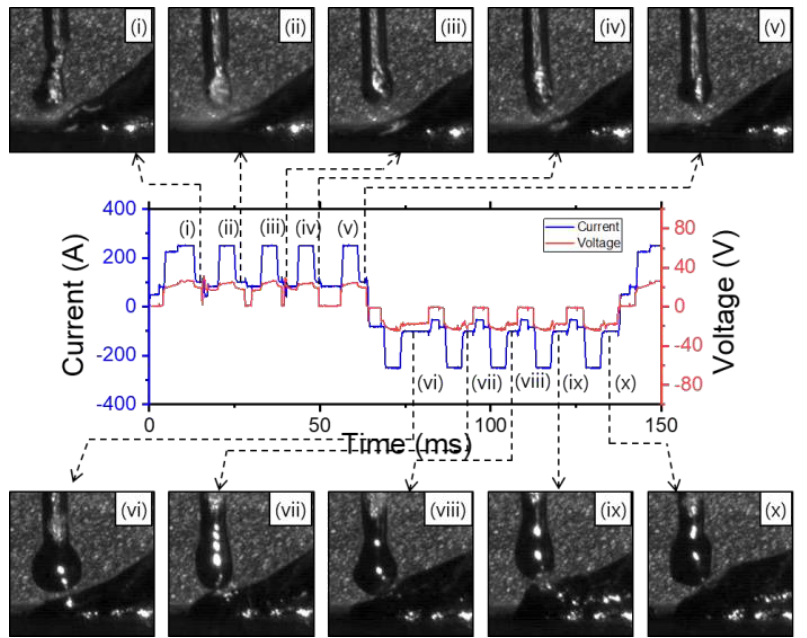
Figure 9. Observation of droplet transfer and molten pool deformation throughout the EP ( i – v ) and EN ( vi – x ) phases. The images were captured under the conditions of a welding speed of 0.3 m/min, five pulse repetitions, and an R EN of 0.5.